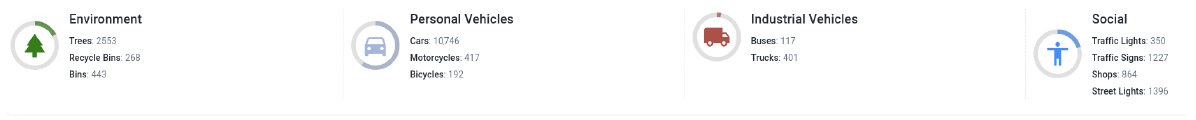
Figure 8. Aggregated results of the StreetScouting UI for a sample